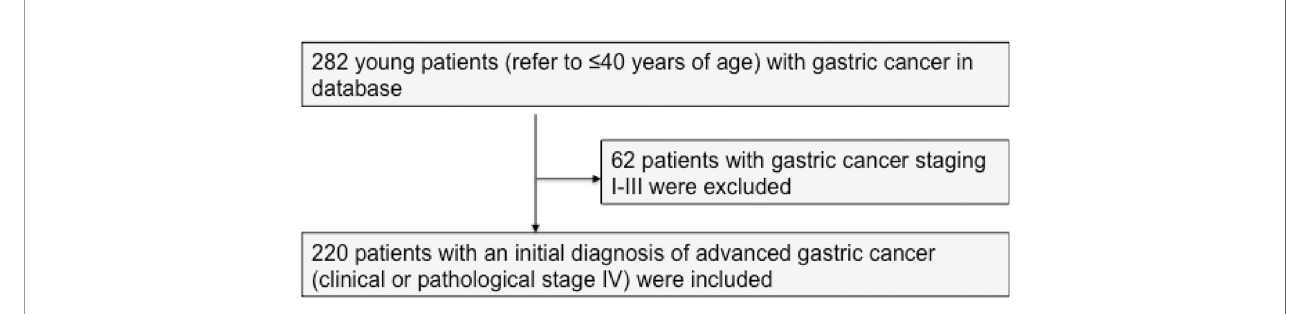
FIGURE 1 | CONSORT